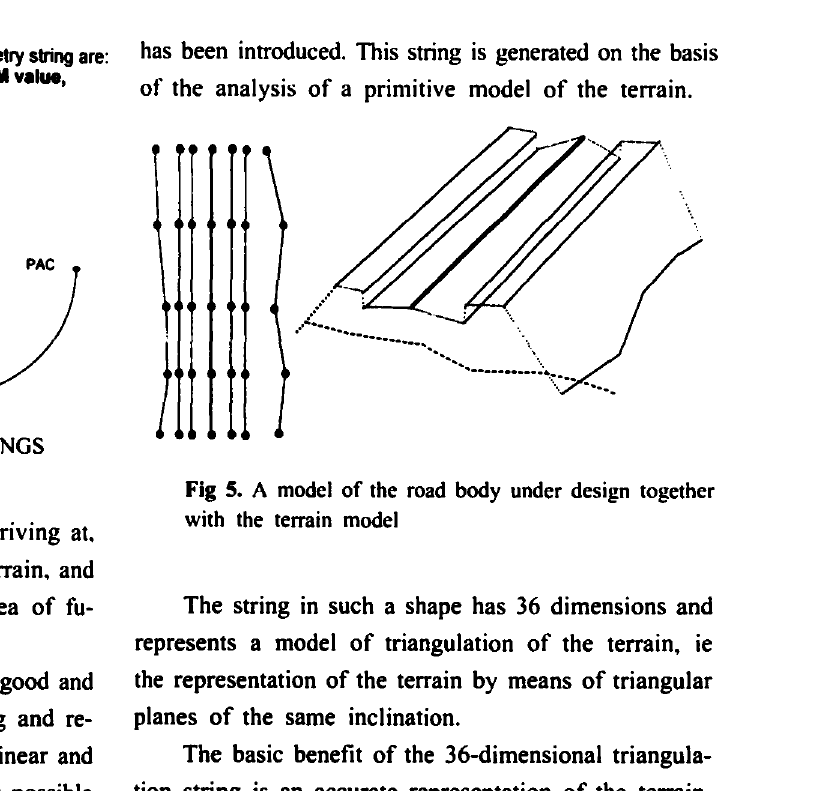
Fig 4. Multidimensional GEOMETRIC STRINGS Or else, a number of models together arriving at, for example, a designed road body and the terrain. and obtaining the results regarding volume of area of fu ture earth or surface work.